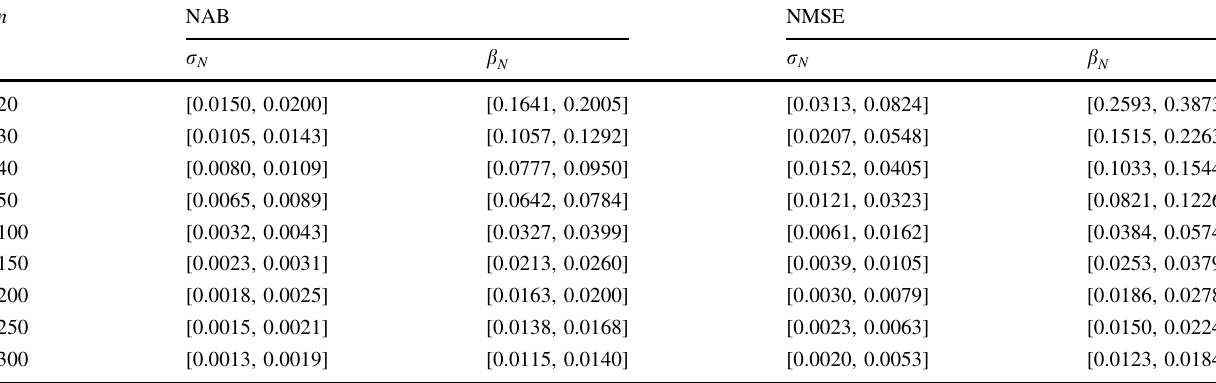
Table 2 Simulated average neutrosophic biases and MSEs of parameters when r N 2 1 ; 2 ½